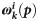
Graphs of the attitude values (on the y-axis)
ωki(p)
of agent i in orange, and
ωkj(p)
of agent j in green for possible positions p on a worldview (on the x-axis). The values ωki(p) depends on the acceptable positions of i. and the one of ωkj(p) depends on the acceptable positions of j. For both agents, the acceptable positions are recognizable in the figure as going from -0.85 to -0.15 on the x-axis since these positions are valued 1 on the y-axis Agents i and j have a similar acceptance segment but a different m.a.position (see the orange and the green squares respectively). Thus they have a different margin(h) (outlined by the orange and green arrows). The green agent, having a smaller margin(h) decreases more quickly the attitude given to positions outside its acceptance segment. A similar position 0.2 is valued -0.46 by the green agent while it is valued -0.24 by the orange agent.